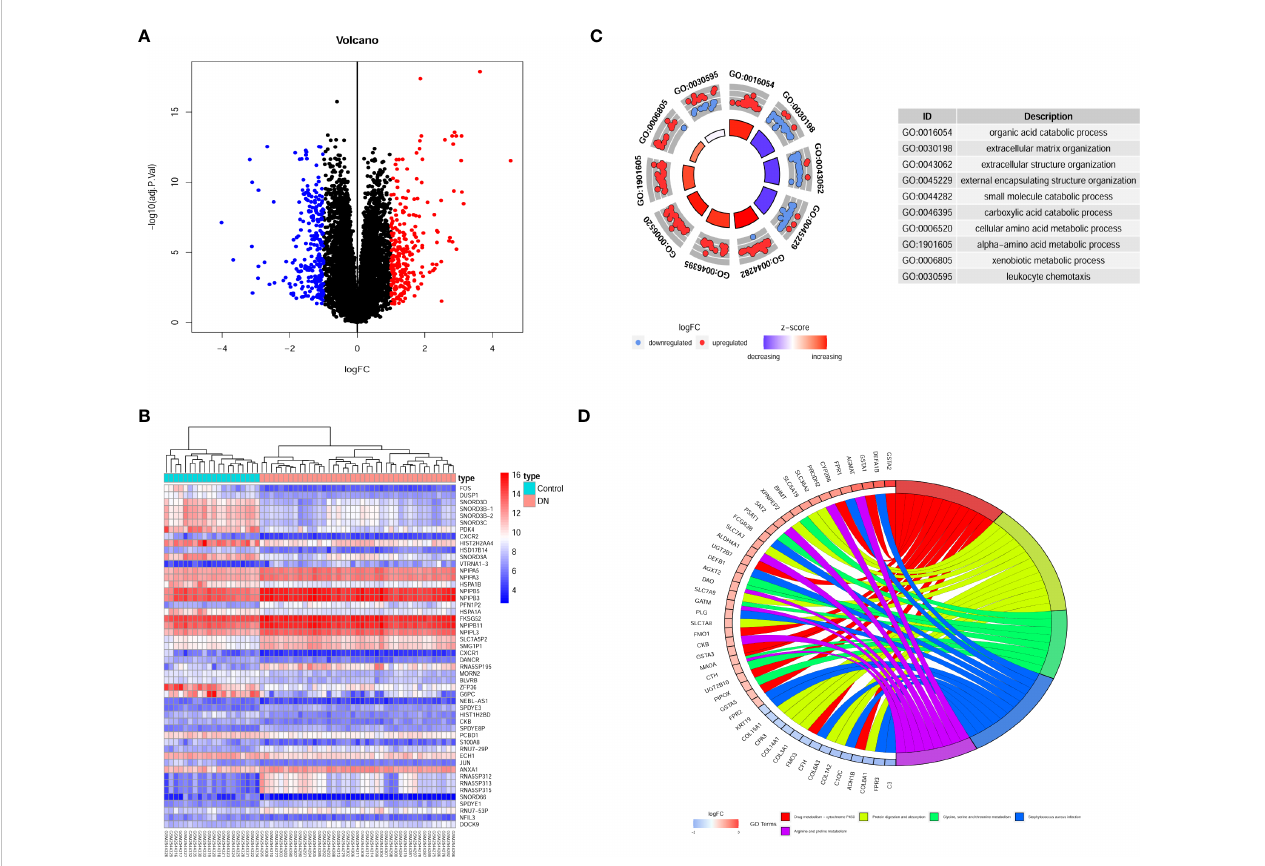
FIGURE 2 Gene recognition and function enrichment of DEGs in GSE96804 database. (A) Volcano-map of DEGs (DEGs: |log2FC| > 1, adjusted P<0.05). (B) Heatmap of the DEGs. (C) Circle map of GO enrichment analysis. (D) Circos map of the KEGG enrichment analysis. DEGs, differentially expressed genes; GO, Gene Ontology; KEGG, Kyoto Encyclopedia of Genes and